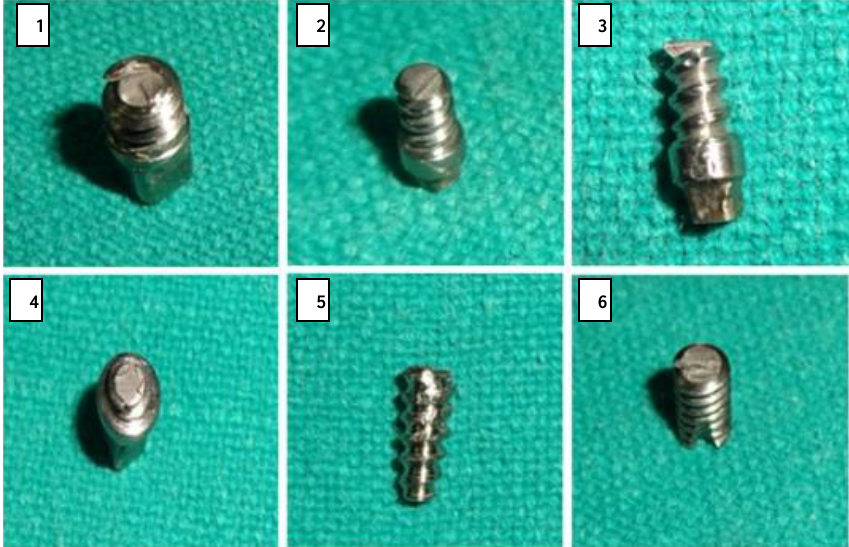
Fig. 1. Macroscopic view of the fractured retrieved